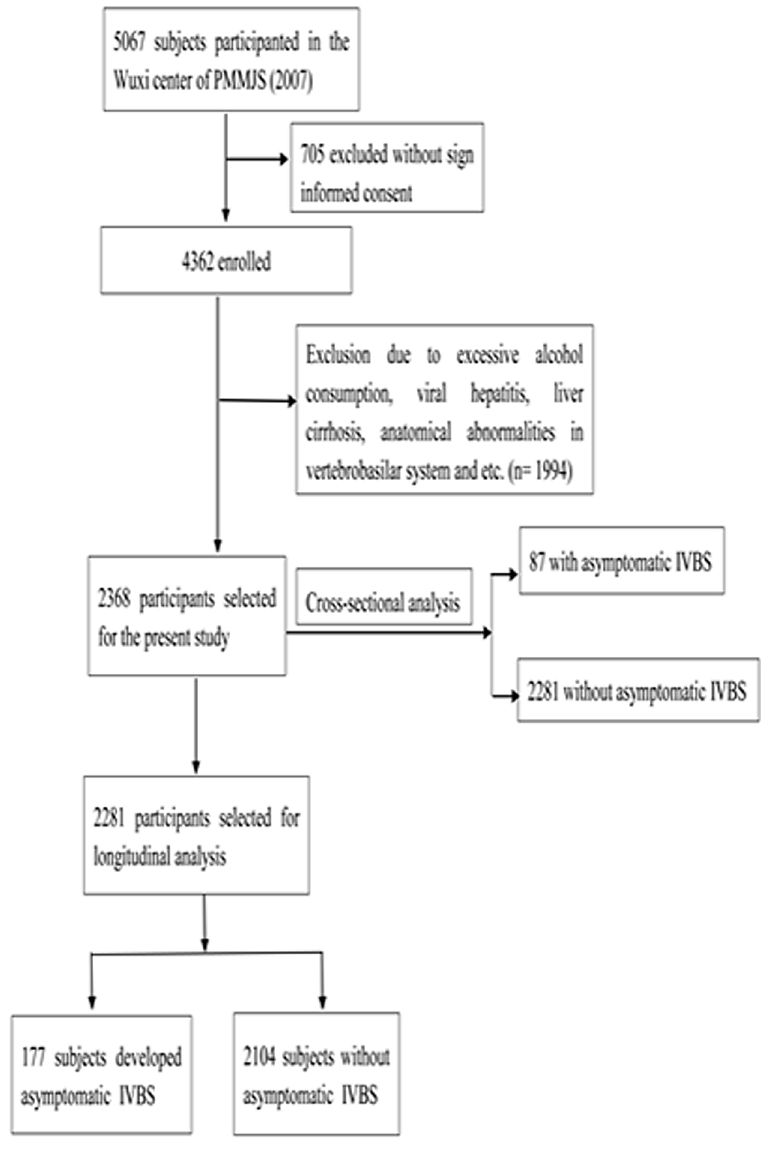
Fig 1. Study flow diagram for the included